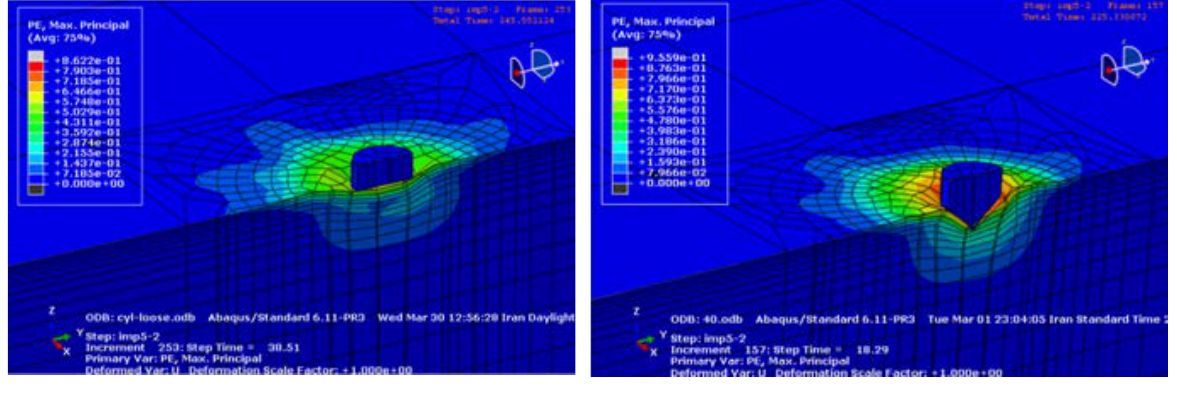
Fig. 9. Maximum principal strain contours at 5 th blow count created in very loose, loose and medium sand by a